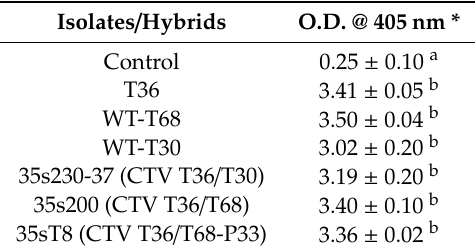
Table 2. ELISA result of source plants used for aphid transmission of